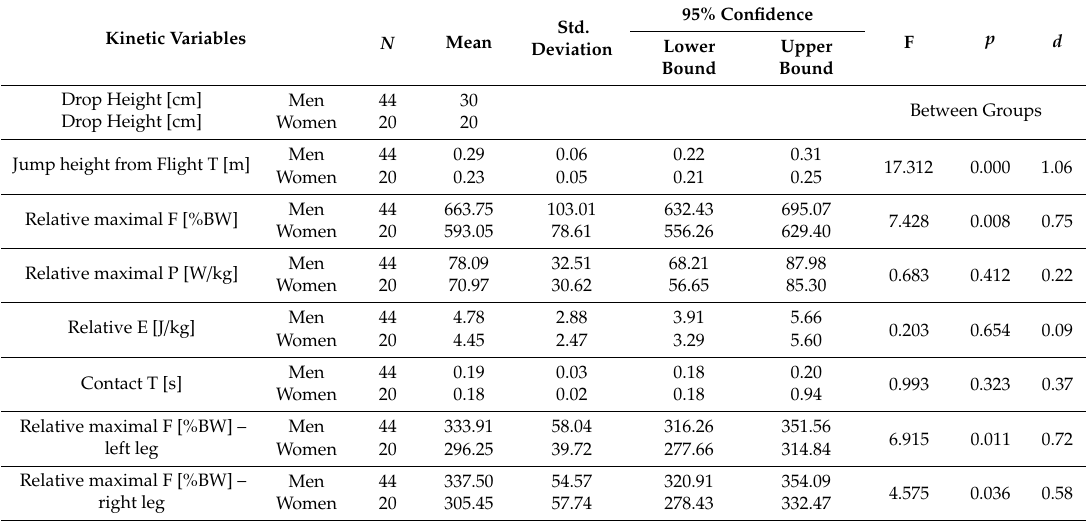
Table 2. Descriptive statistics of selected kinetic variables of CMJ during drop jumps from 20 cm (female) and 40 cm (male)